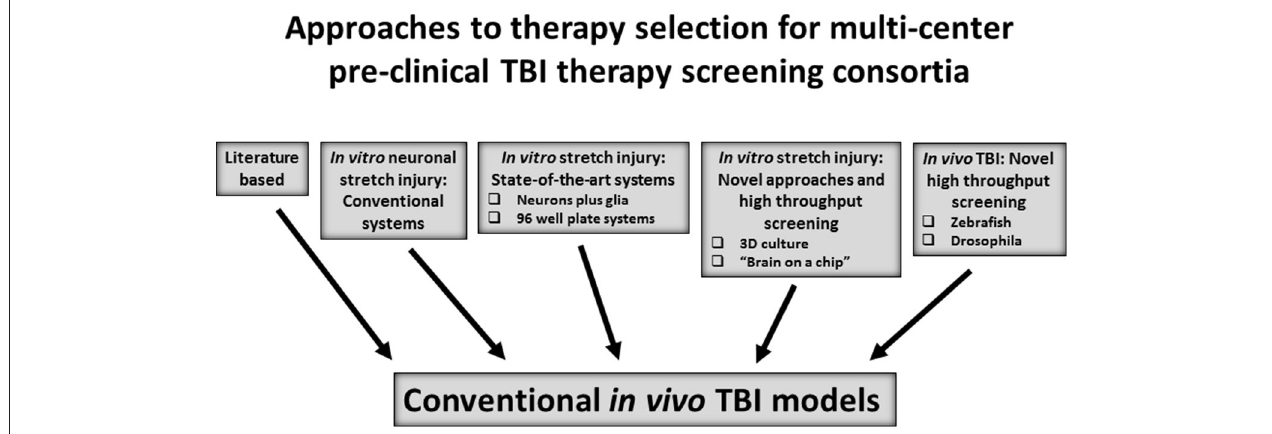
FIGURE 1 | Approaches to select and/or advance therapies to in vivo therapeutic screening in conventional rodent and/or large animal models of traumatic brain injury